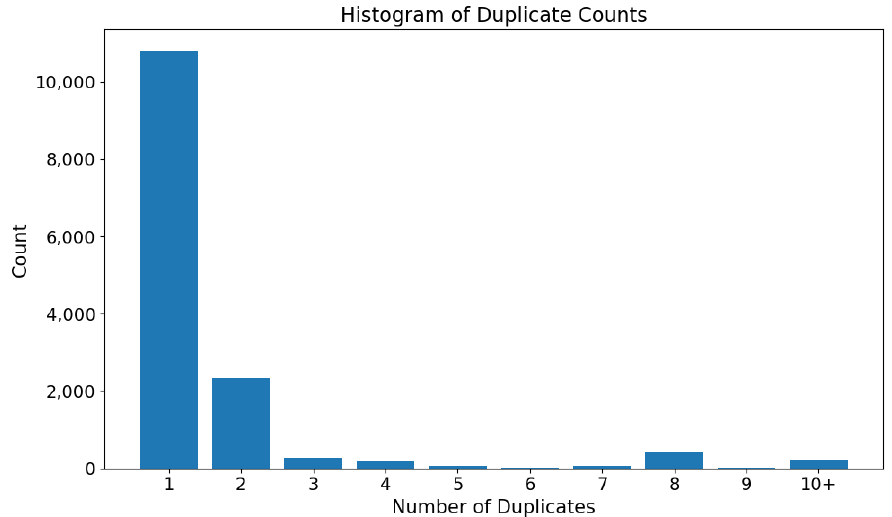
Figure 3. Histogram of the total number of repetitions of the post content in the dataset. Duplicates are counted as posts with identical texts.